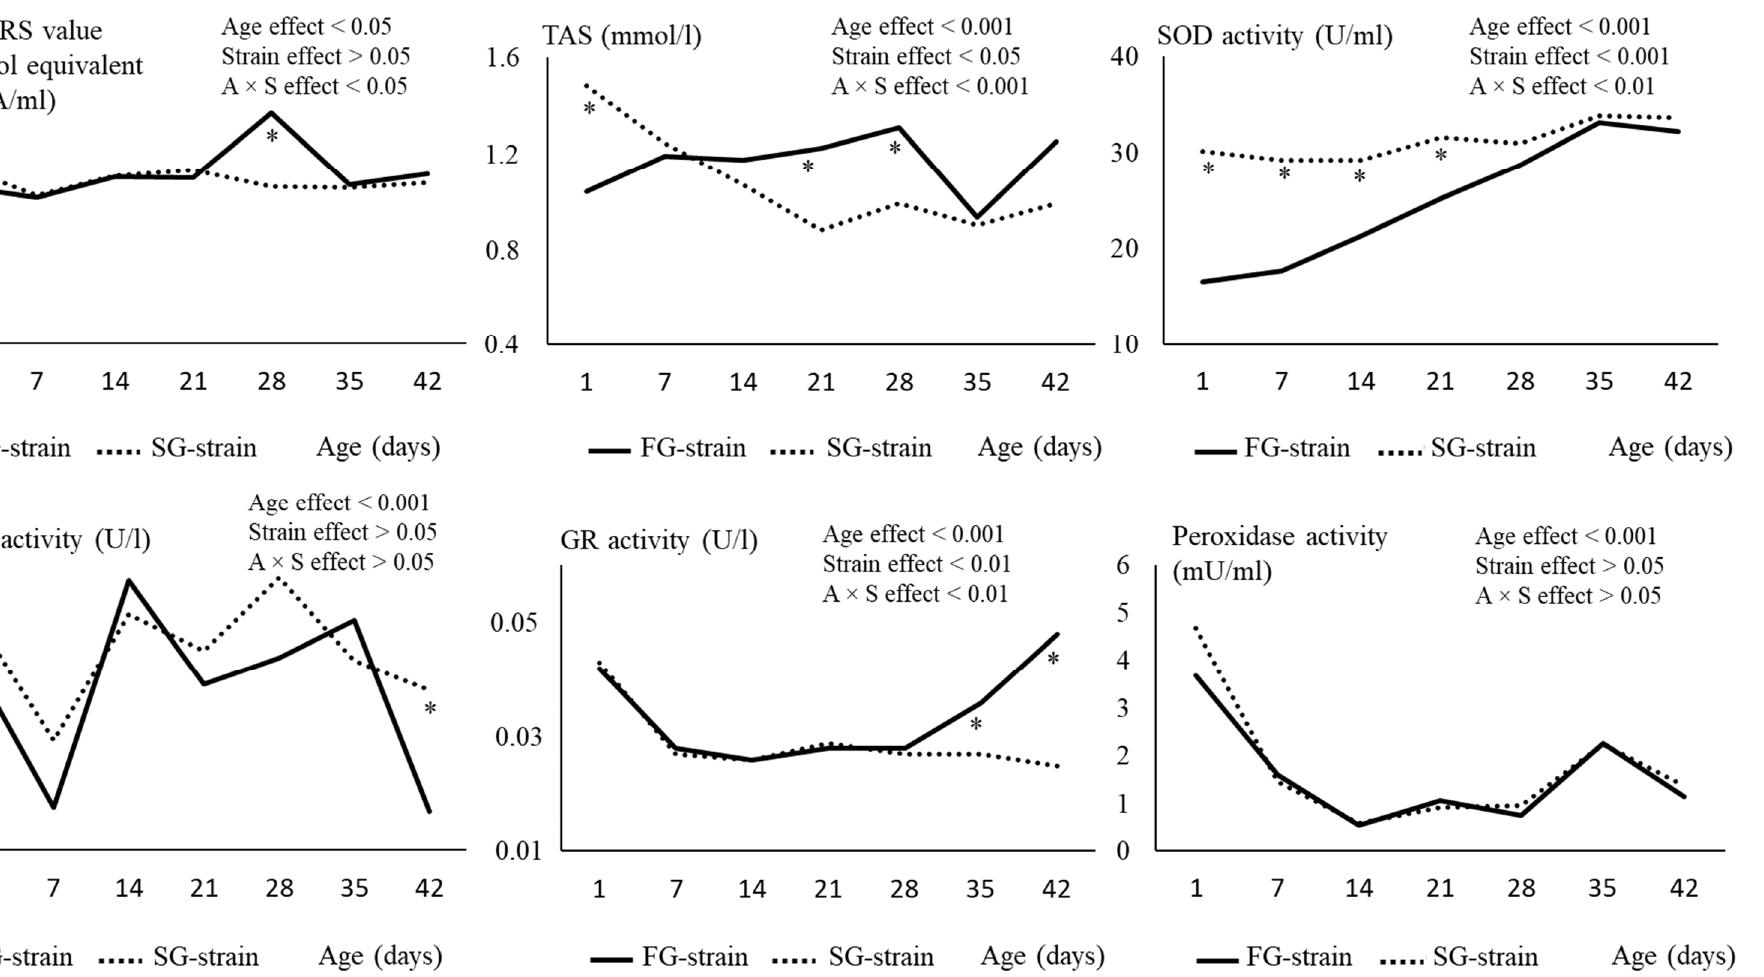
Figure 2. Effects of age (A) and strain (S) and their interaction on plasma TBARS, TAS and SOD, GPx, GR, and peroxidase activity. Data are presented as the means; n = 10 per strain and per age. *: Significant difference ( p < 0.05) between strains for a given age; FG = fast-growing, SG = slow-growing.